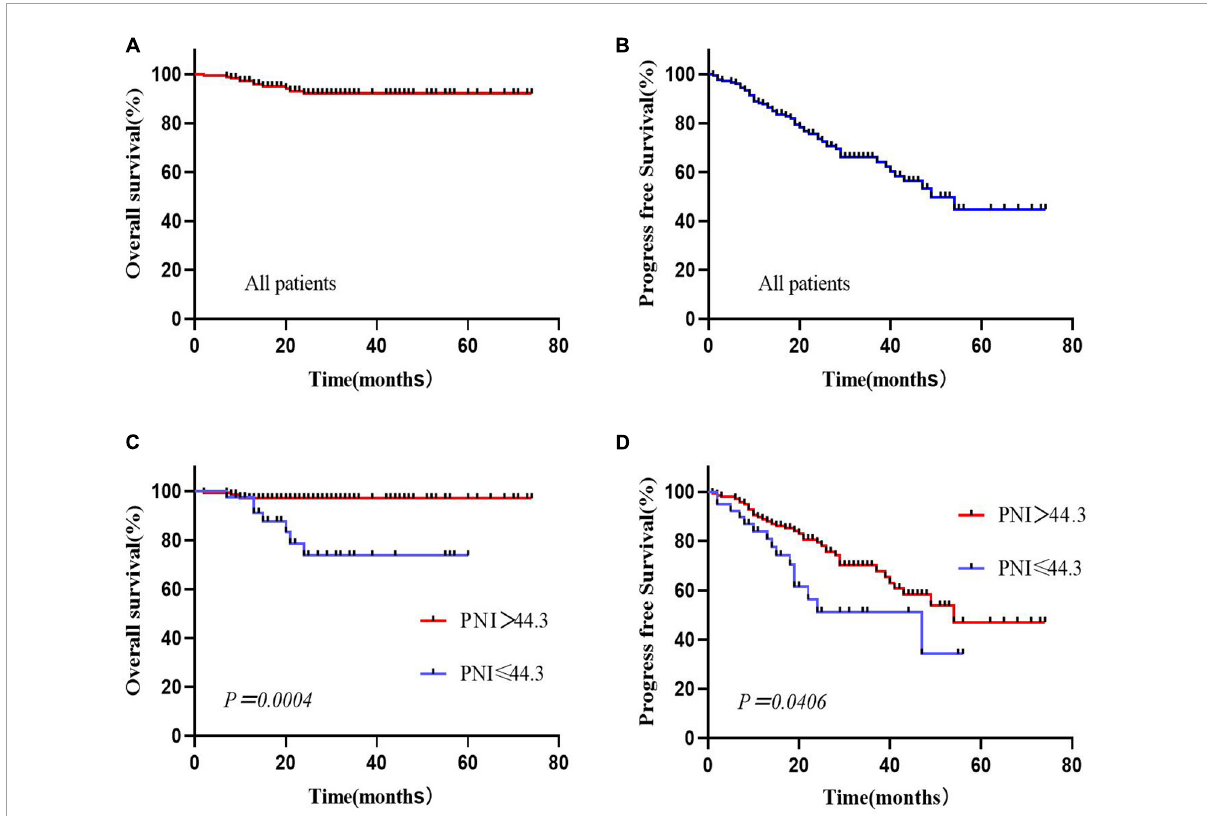
FIGURE2 Overall survival and progression-free survival curves for all patients (A,B) and stratified by the prognostic nutritional index (C,D)